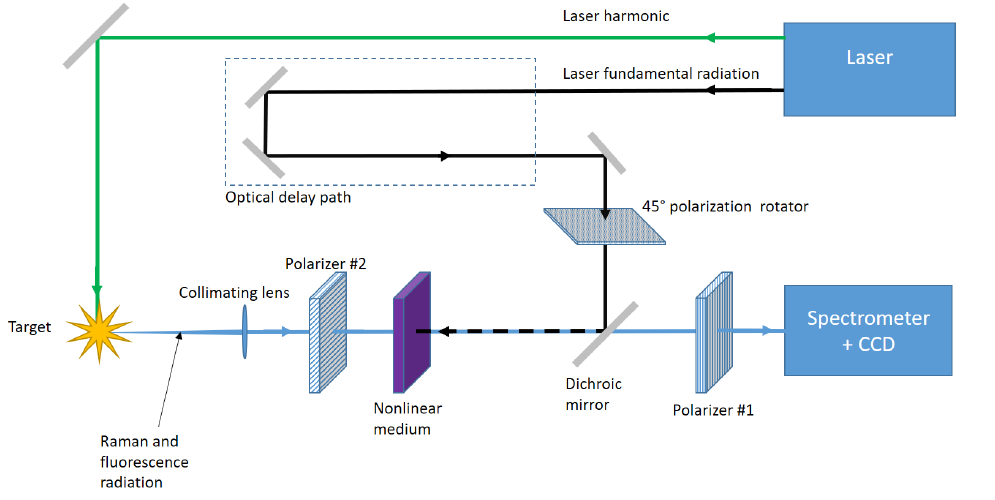
Figure 6. Experimental setup of a Kerr cell optically activated exploiting the properties of a nonlin- ear